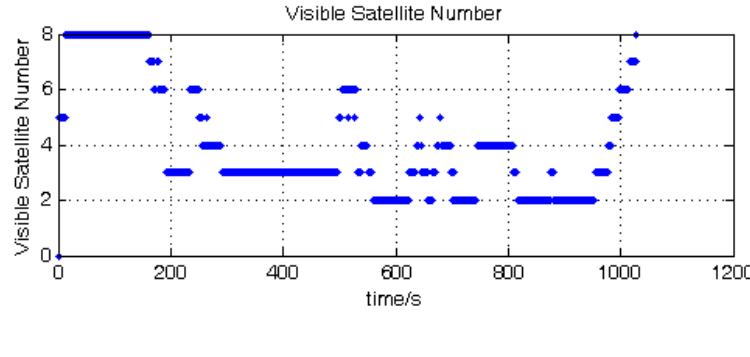
Figure 8. Satellite visible number.